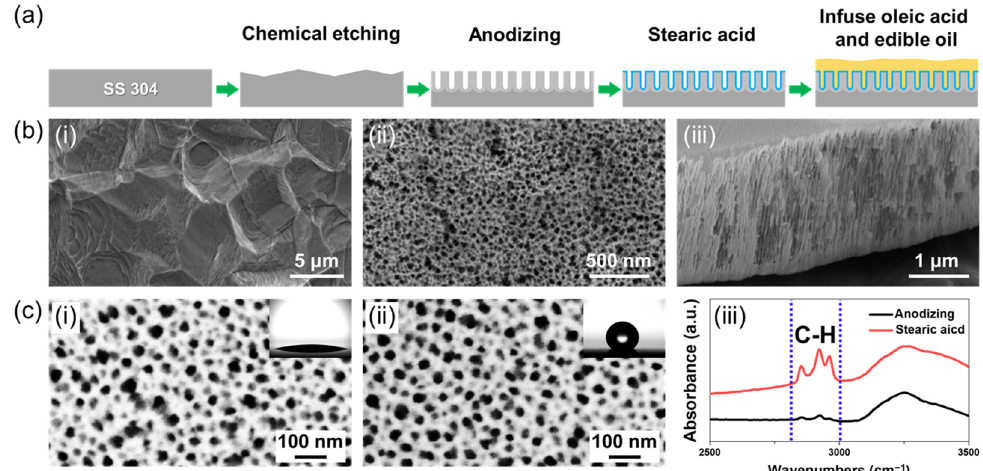
Figure 1. ( a ) Schematic procedure for sample preparation with chemical etching, anodic oxidation, hydrophobizing, and oil impregnation. ( b ) SEM image of ( i ) chemically etched SS304 surface, ( ii ) surface, and ( iii ) cross-section of the anodic oxide of SS304. ( c ) SEM image of ( i ) before and ( ii ) after the hydrophobizing by immersing in stearic acid, and ( iii ) FT-IR spectra of anodic oxide surface with and without hydrophobizing (i.e., immersing in stearic acid).